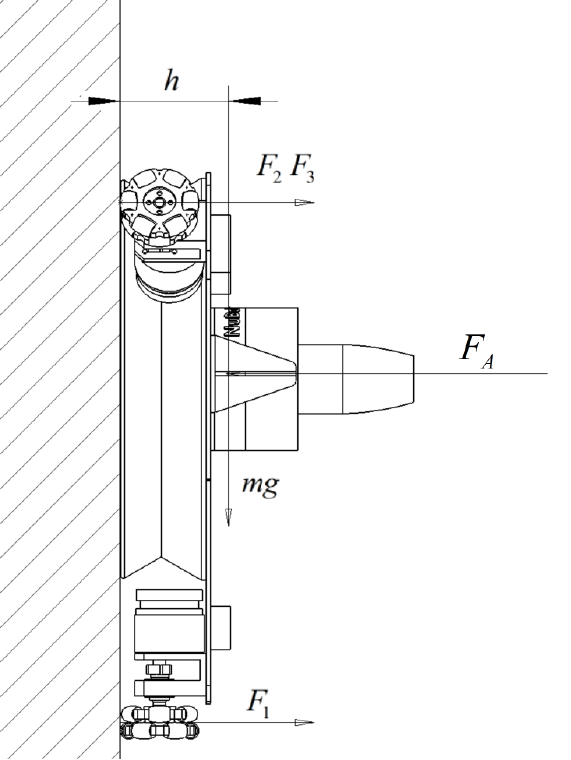
Figure 4. Schematic diagram of the forces on the wall of the robot